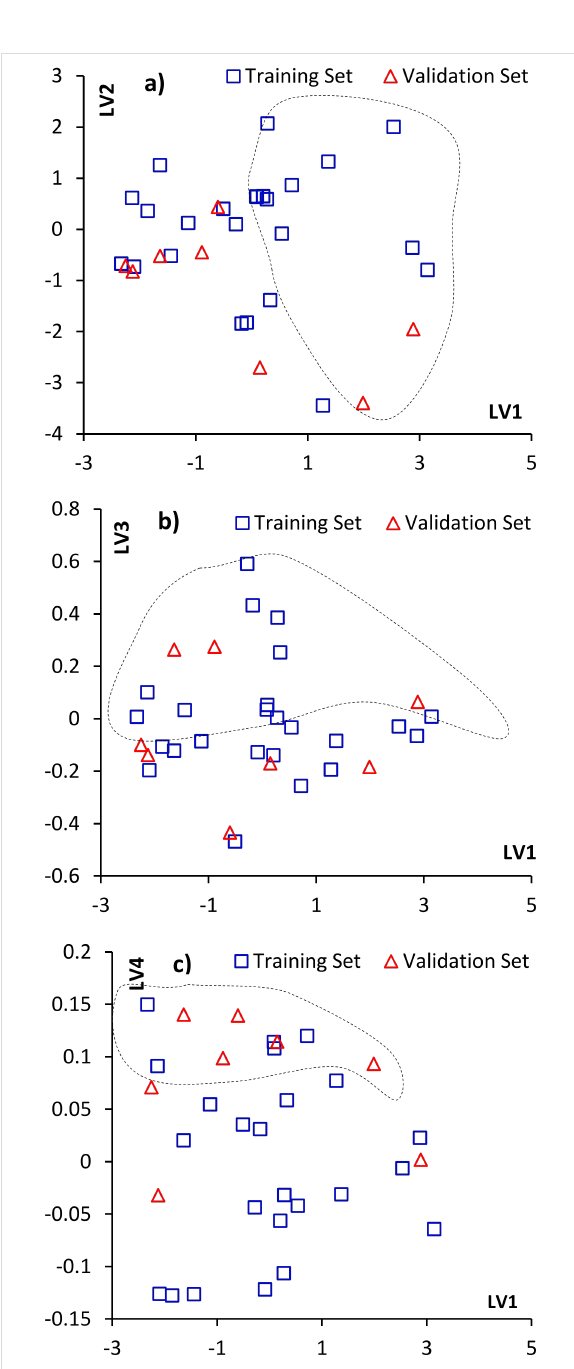
Figure 3: Score plots of dioxin congeners selected for the training ( □ ) and validation ( Δ ) set in the space of latent vectors. Marked areas are: a) more than 50% of H atoms, and halogenation only in 2,3,7,8 posi- tions for b) unsymmetrical halogen atom (preferably Cl) and c) unsym- metrical substitution (preferably